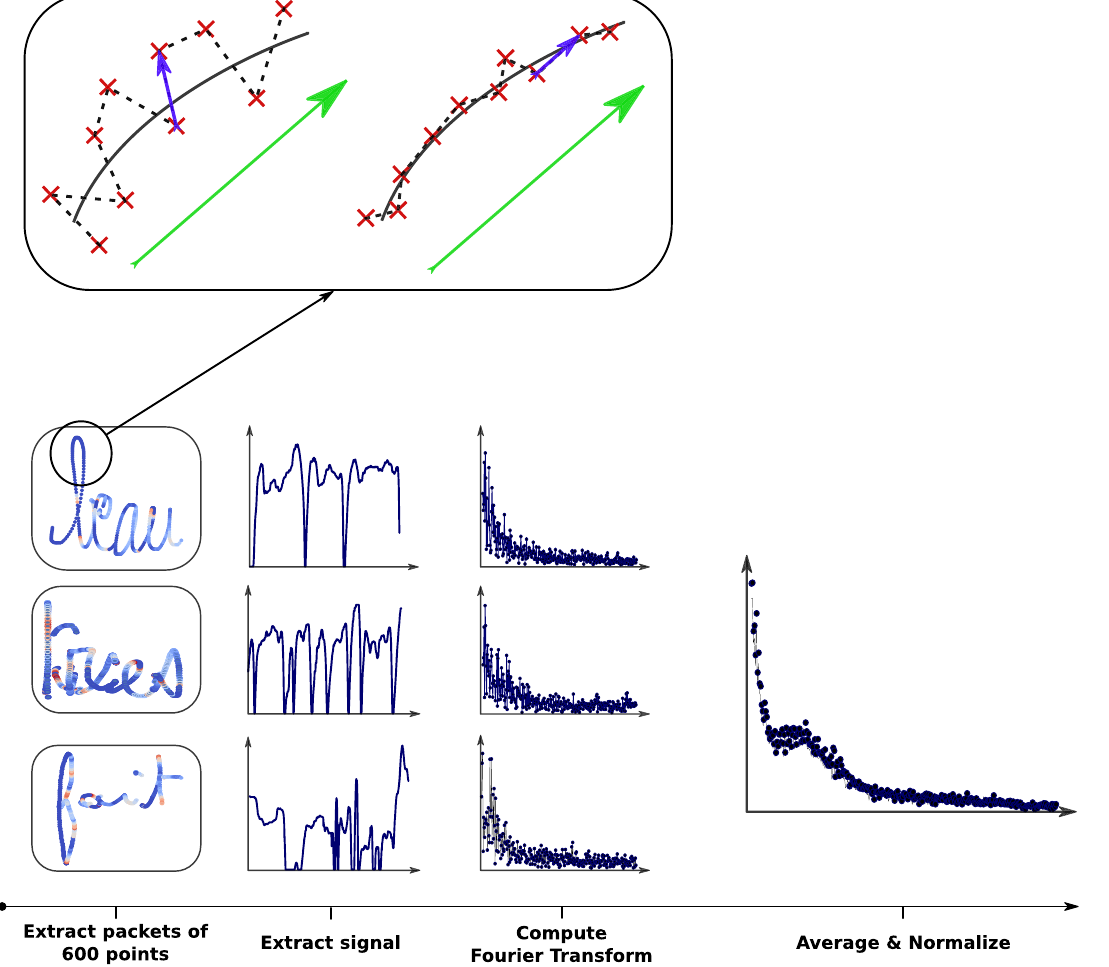
Fig. 4 The whole process used to extract the frequency spectrum of our signal. (1) We fi rst divided the BHK text into bins of 600 points. (2) For each bin, the signal was extracted. (3) We then computed the Fourier transformation of each signal. (4) We took the average of all signals and fi nally performed a normalization. At the top of the fi gure there is an example of a signal extracted from the data: the red dots are the point coordinates recorded by the device during handwriting. The vectors in blue are “ local' ” vectors linking two consecutive points. The vector in green is the “ global ” vector (average of the nine blue vectors) representing the global direction of the handwriting. The cross product of these two vectors gives us an indication of the smoothness/shakiness of the handwriting. The image on the right comes from a writer with smoother/ less shaky handwriting than the one on the left. The cross product operation will detect this difference. The fi gure comes from 21